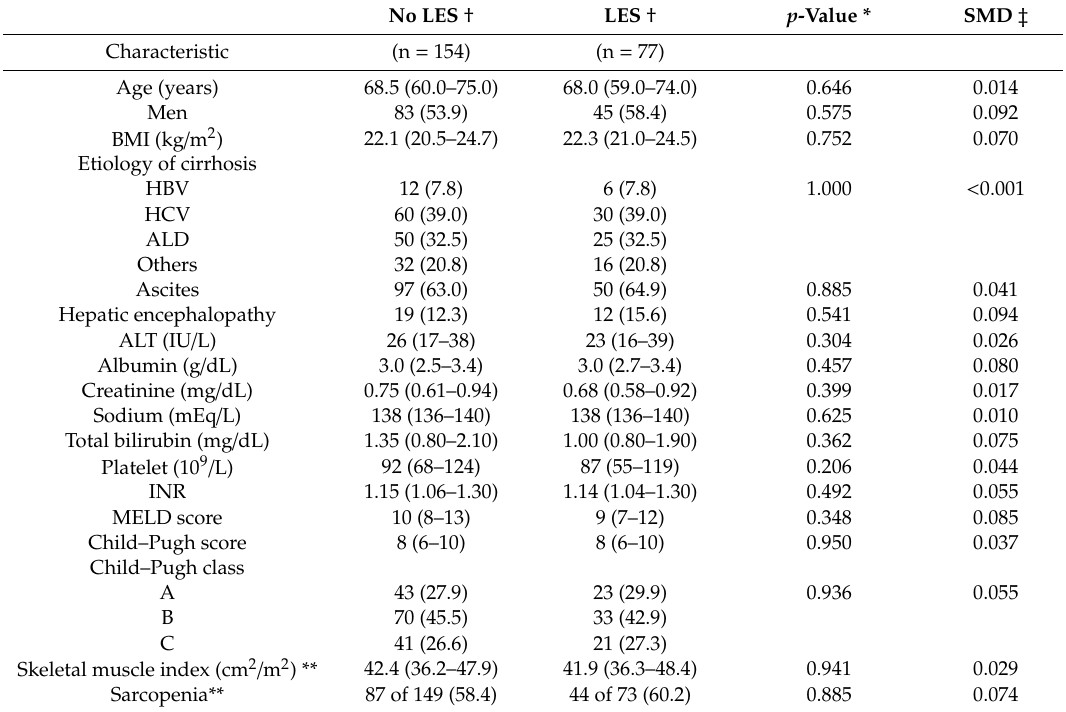
Table 2. Clinical characteristics of 77 LES-treated patients and 154 untreated patients after propensity score matching